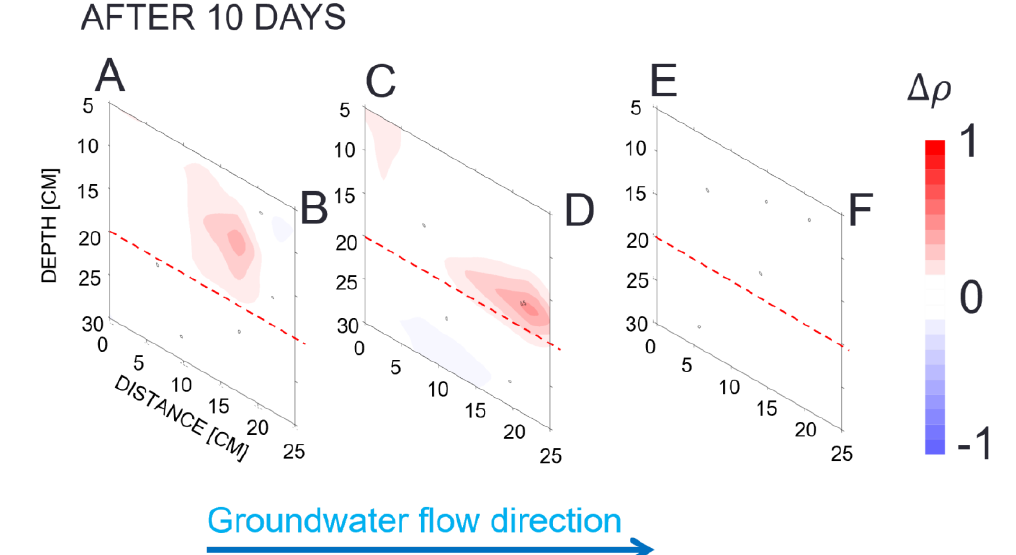
Figure 3. CHERTs after 10 days from the contamination event. A moderate increase in resistivity values can be appreciated in the vadose zone above the groundwater